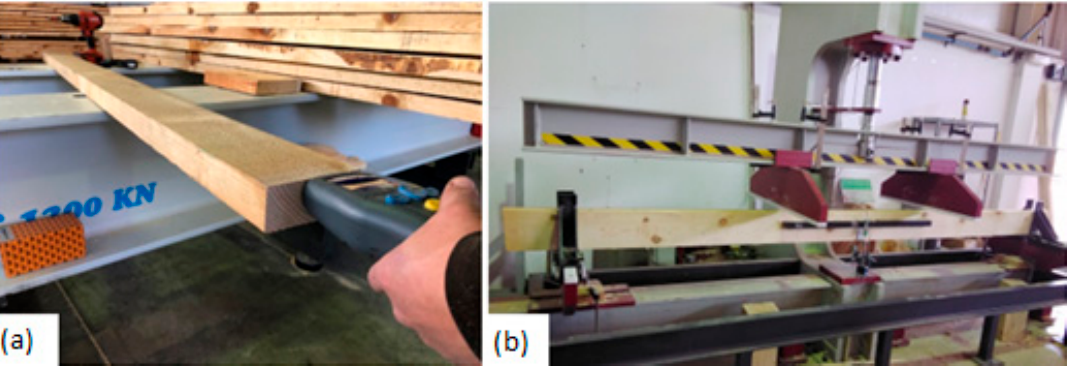
Figure 4. Machine grading ( a ) and bending test ( b ).